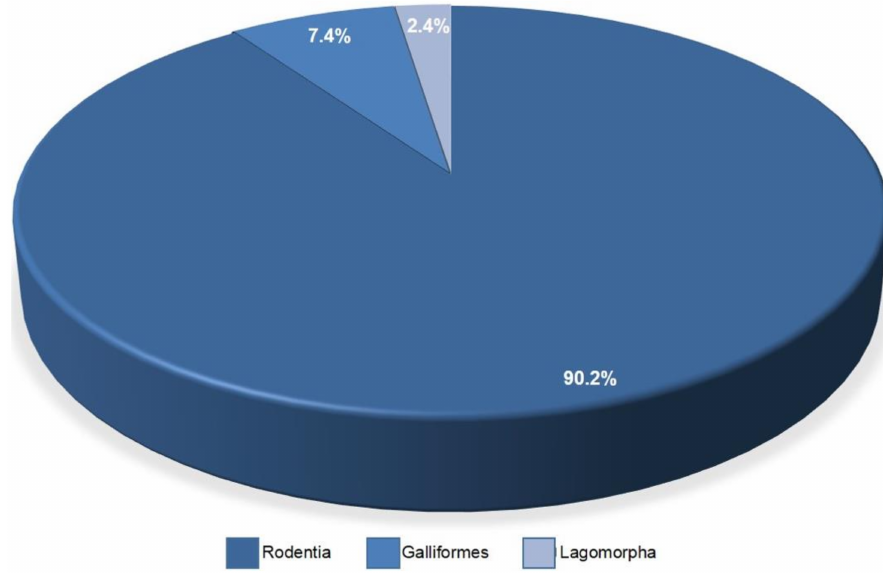
Figure 10. Types of animals used in the in vivo assays.